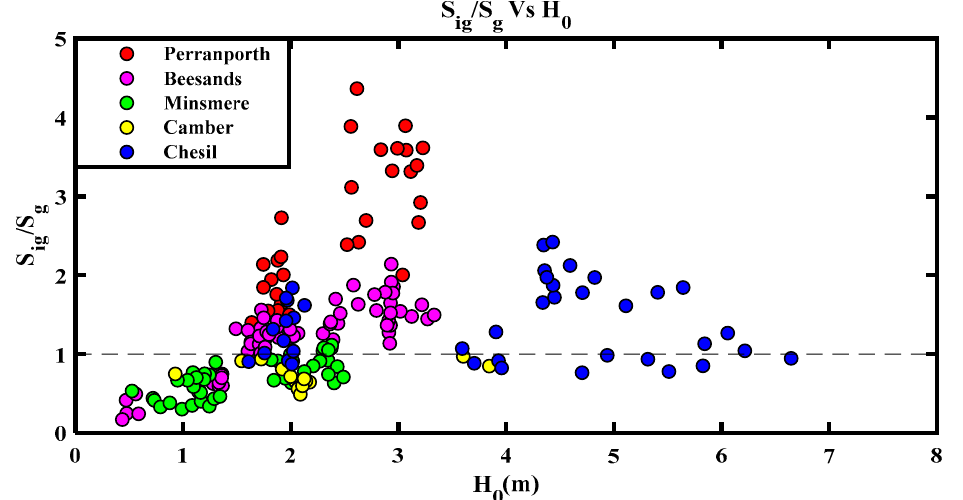
Figure 6. S ig / S g against H 0 . Transition from S g - (below) to S ig -dominated (above) (horizontal dashed line).